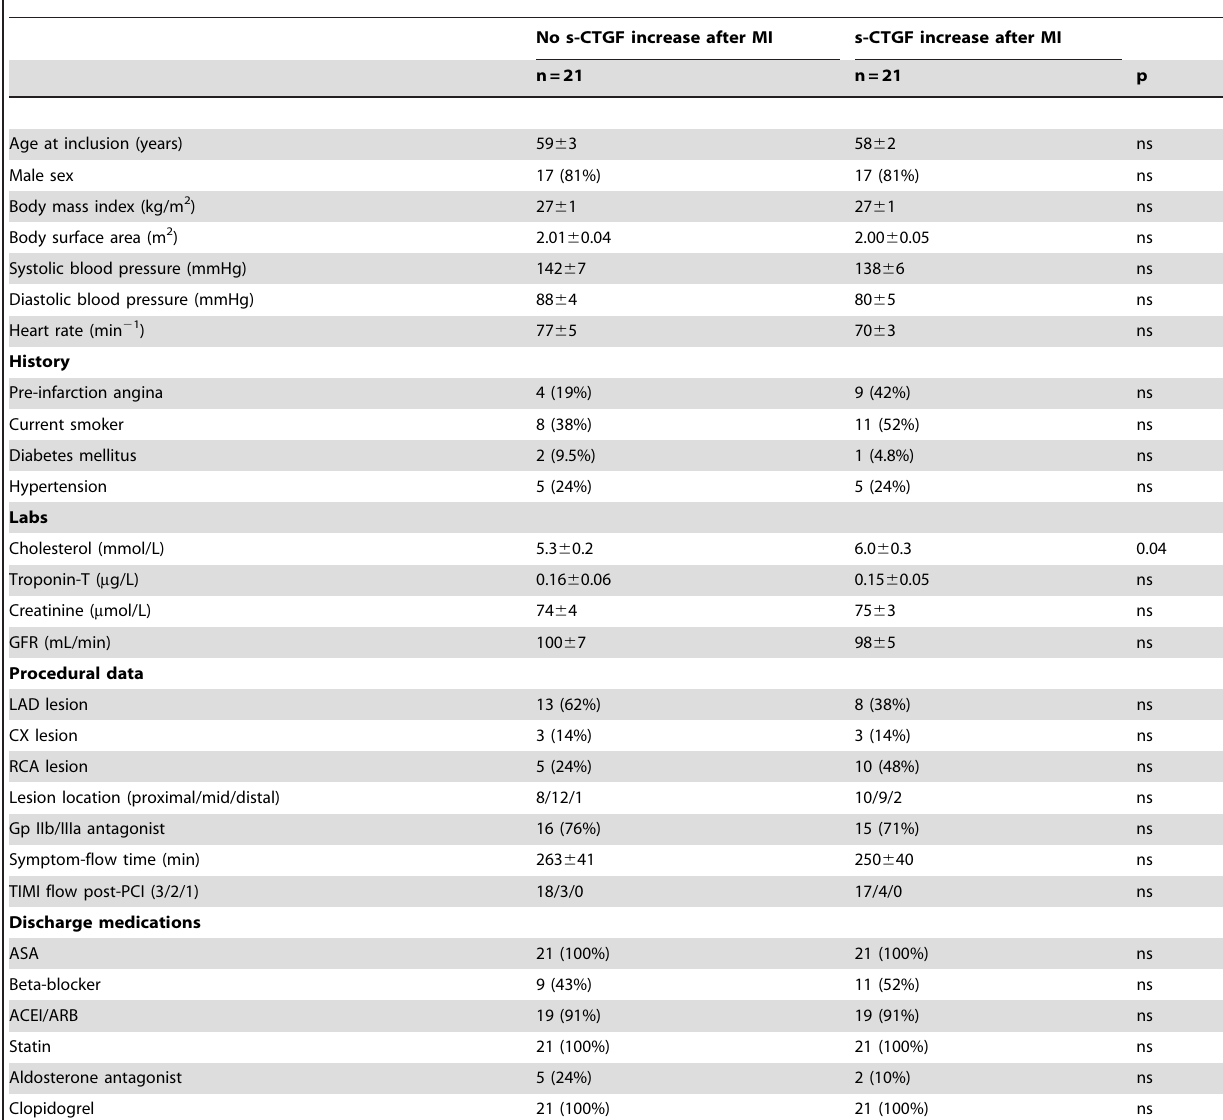
Table 1. Baseline characteristics of patients with or without increase of serum-CTGF levels after